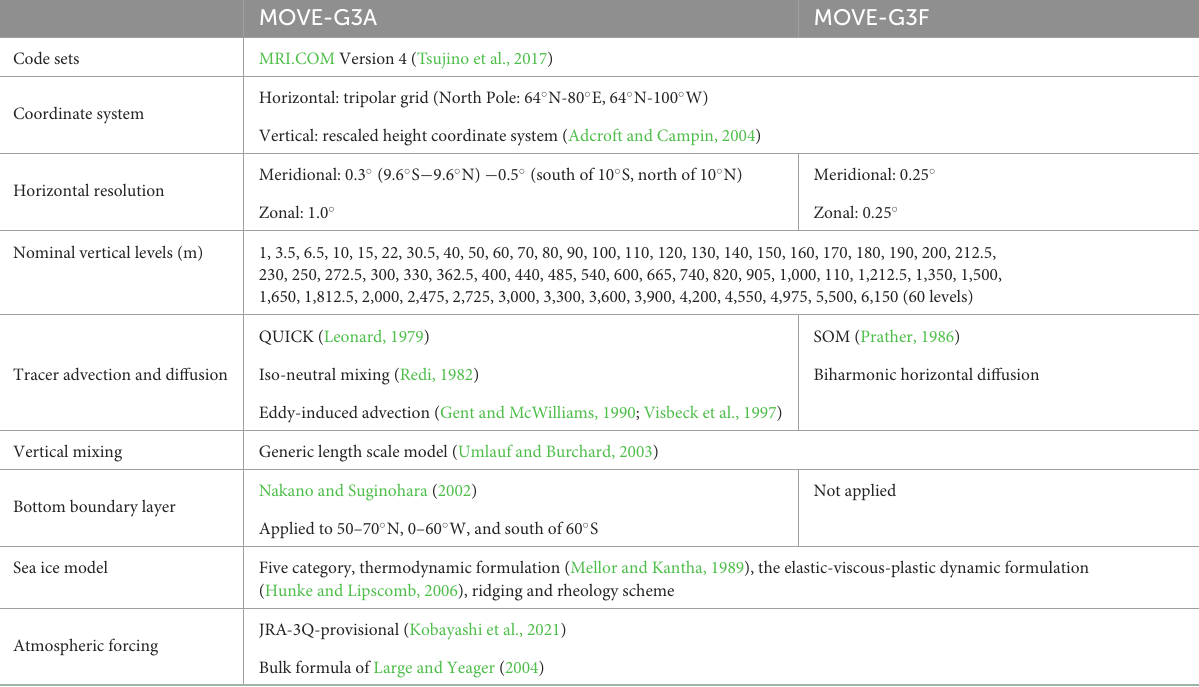
TABLE 1 Main specification of the ocean models used in MOVE-G3A and MOVE-G3F.